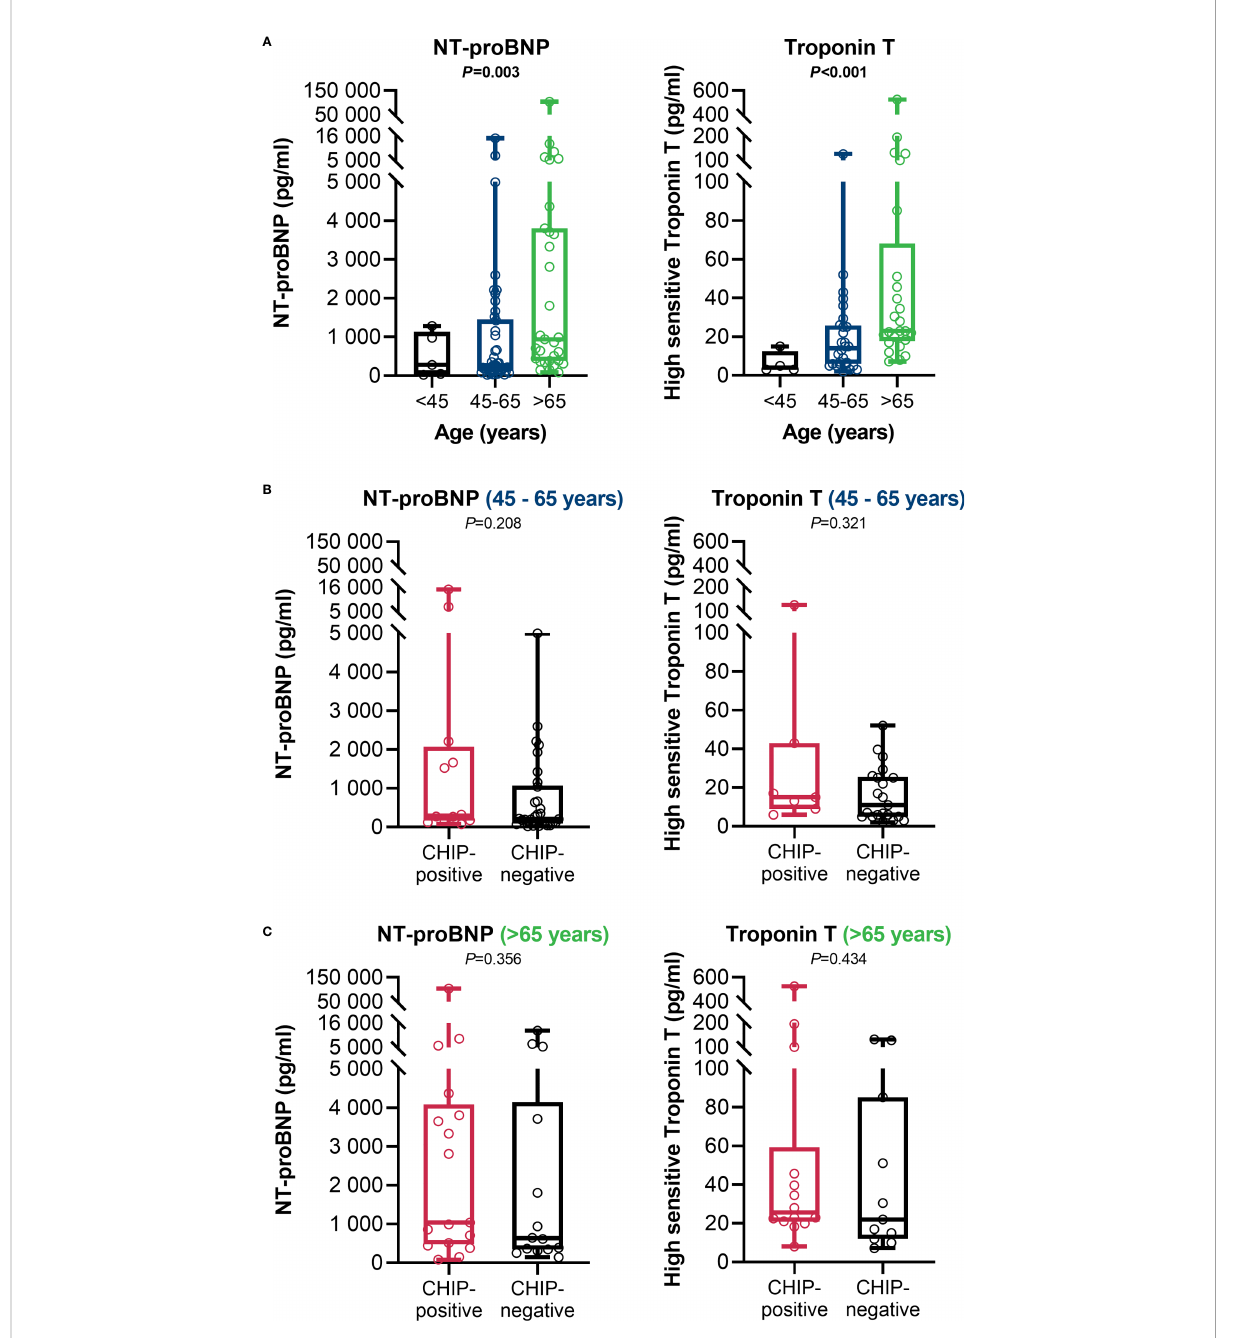
FIGURE 4 Age-adjusted cardiac function related clinical parameters at admission. (A) NT-proBNP (< 45: n=5; 45 – 65: n=42; > 65: n=31) and high sensitive Troponin T (<45: n=4; 45 – 65: n=28; >65: n=25) in comparison between the age groups. Group comparisons were done using Kruskal-Wallis test. (B) NT-proBNP (CHIP-positive: n=12; CHIP-negative: n=30) and Troponin T (CHIP-positive: n=7; CHIP-negative: n=21) in the 45 – 65 age group. (C) NT-proBNP (CHIP-positive: n=17; CHIP-negative: n=14) and Troponin T (CHIP-positive: n=14; CHIP-negative: n=11) for the > 65- year-olds. Group comparisons were performed by two sided Mann – Whitney U-test. Each data point represents an individual patient. Horizontal line within the box marks the median, boxes depict the IQR, and whiskers indicate the total range. Statistically signi fi cant results (P ≤ 0.05) are highlighted by bold